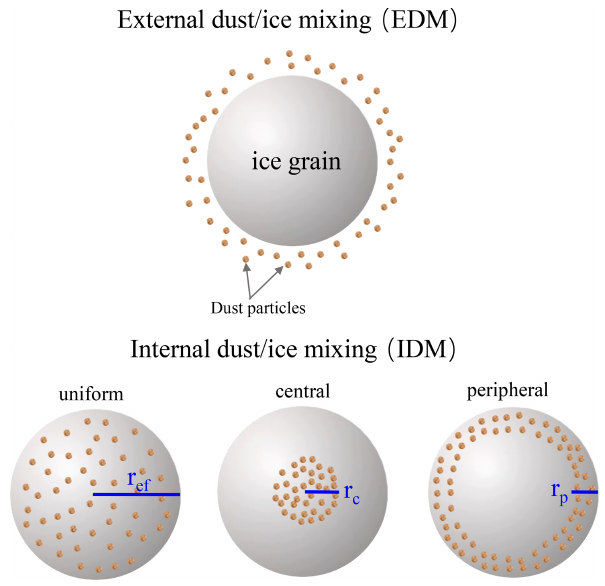
Figure 2. Schematic depicting various mixing scenarios of snow grains and dust particles.